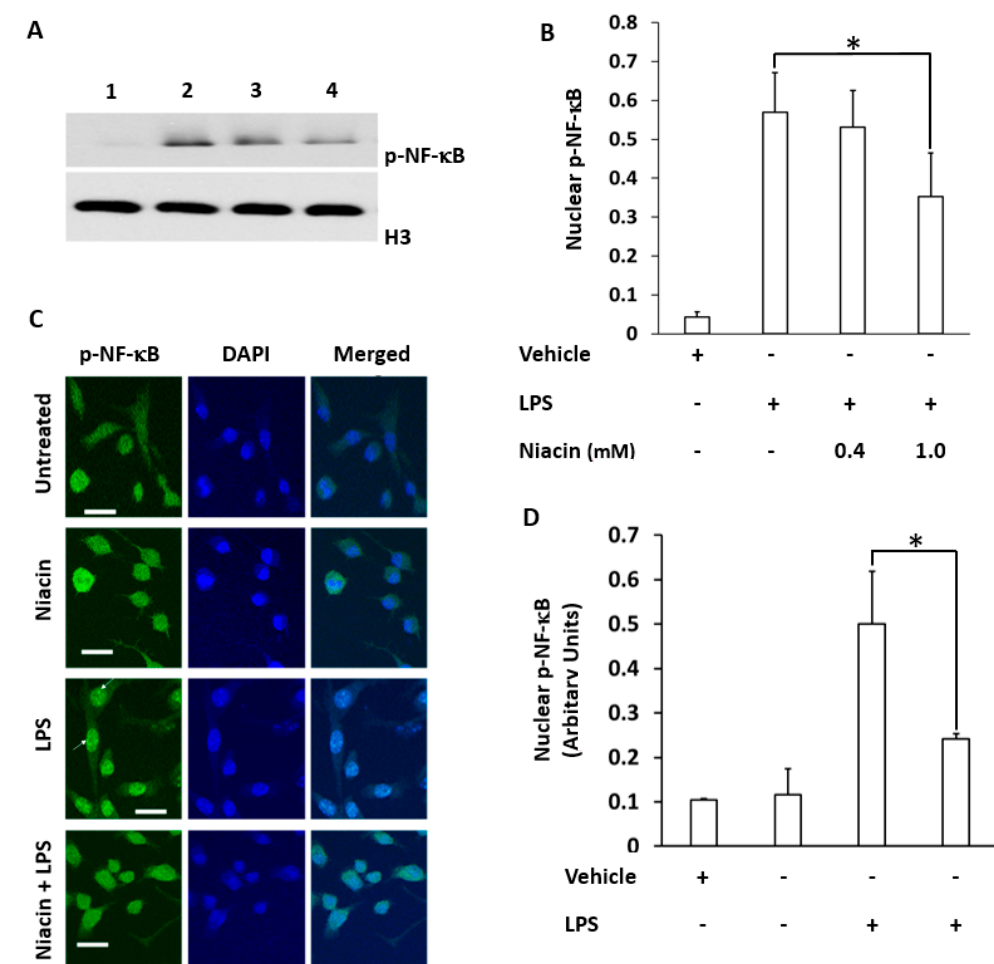
Figure 2. Inhibition of the translocation of LPS-induced phospho-Nuclear Factor- κ B (p-NF- κ B) into the nucleus of RAW264.7 cell line by niacin. ( A ) Western blot of p-NF- κ B protein in nuclear fractions of RAW264.7 macrophages. No treatment (lane 1), treated with LPS (lane 2) and treated with LPS in the presence of 0.4 mM (lane 3) niacin and 1 mM niacin (lane 4). Histone-3 (H3) was used as a loading / nuclear marker. ( B ) Densitometric analysis of p-NF - κ B protein normalized to H3 density. Data is presented as Mean ± SD levels of p-NF - κ B from three independent experiments ( n = 3), * p < 0.05. ( C ) Immuno-localization of punctate pattern of p-NF- κ B in the nucleus of RAW264.7 cells before and after LPS stimulation, as well as in the presence and absence of niacin. White arrows show the nuclear translocation of p-NF- κ B in RAW264.7 cells treated with LPS. Bar represents 100 µ M. ( D ) p-NF- κ B + cell count normalized to total cells / high powered field. Data is presented as Mean ± standard deviation (SD) from analysis of six separate high power cell images of at least 10 cells. * p < 0.05.